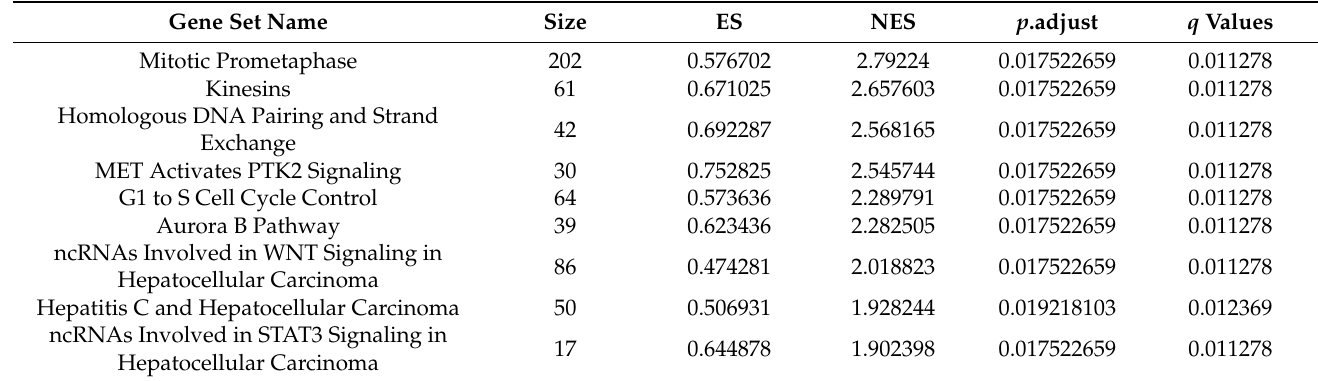
Figure 6. Significantly enriched GO annotations of the POGK gene in HCC. ( A ) GO functional enrichment analysis and KEGG pathway analysis; ( B ) biological process terms; ( C ) cell component terms and ( D ) molecular function terms. GO, Gene Ontology; KEGG, Kyoto Encyclopedia of Genes and Genomes; BP, biological process; CC, cellular component; MF, molecular function. Table 4. Gene sets enriched in the high POGK expression